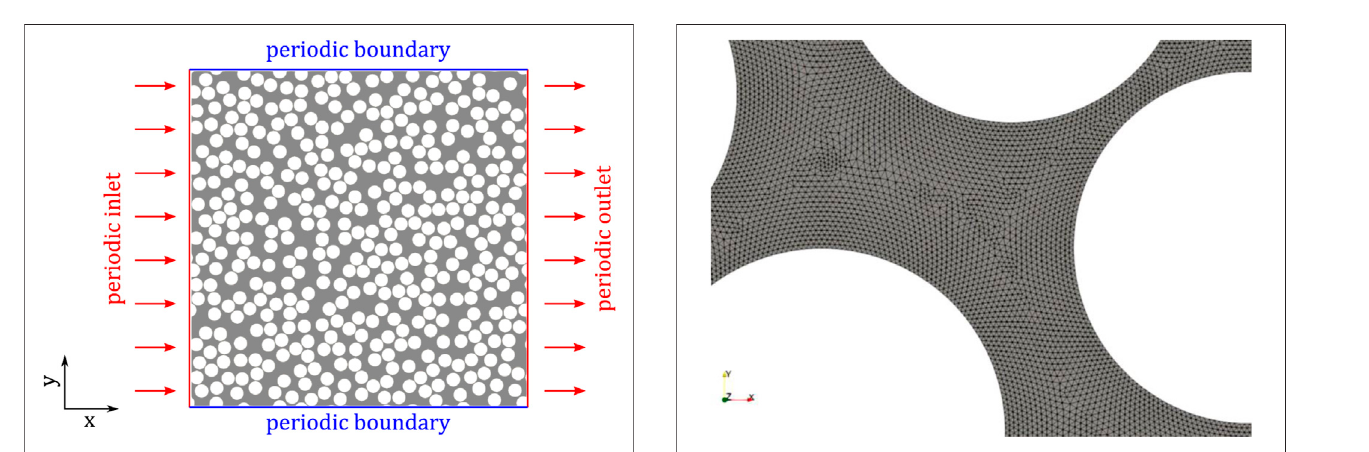
FIGURE 10 | Simulation model with periodic boundaries for transverse simulations in x direction; view parallel to the fi bers; fi ber parallel direction is omitted in the simulations.